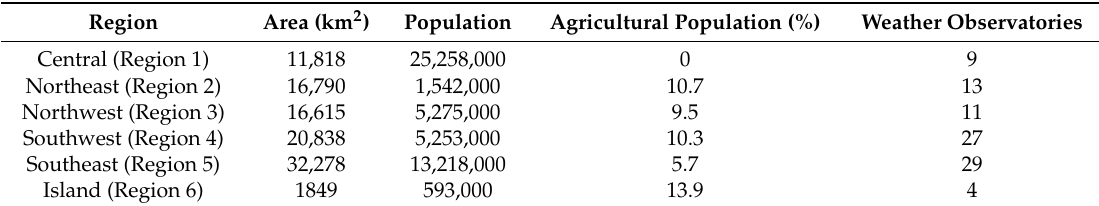
Table 1. Korean six